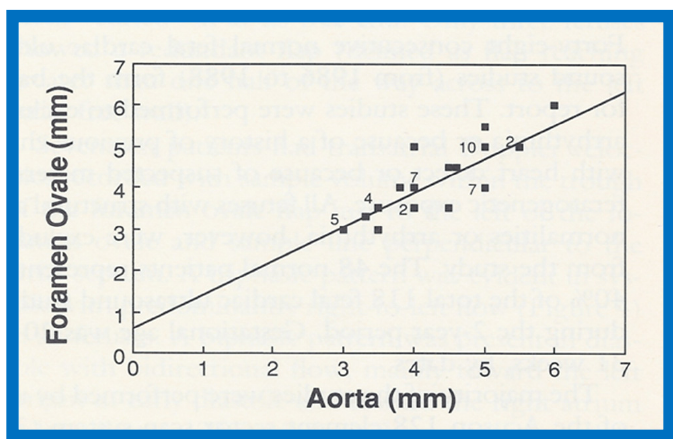
Figure 60. Plot of the diameter of the foramen ovale against diameter of the aorta. The numbers indicate the number of subjects with that particular measurement. Note excellent correlation with an r value of 0.84, y intercept of 0.605 and slope of 0.817. Reproduced from Wilson A.D., Rao P.S, Aeschlimann S. [19].